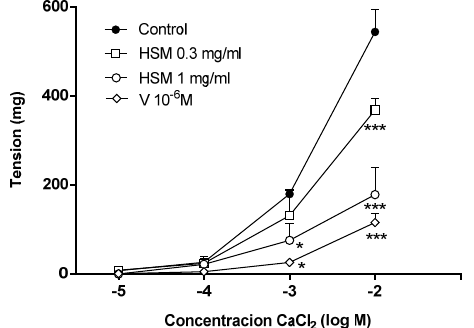
Figure 5. The effects of preincubation with H. stoechas extract (HSM, 0.3 or 1 mg/mL) or verapamil (V, 10 − 6 M) on tension produced by different concentrations of CaCl 2 in rat aorta. Data points are mean ± SEM ( n = 6–8). * p < 0.05 and *** p < 0.001 vs. control (HSM extract solvent alone).